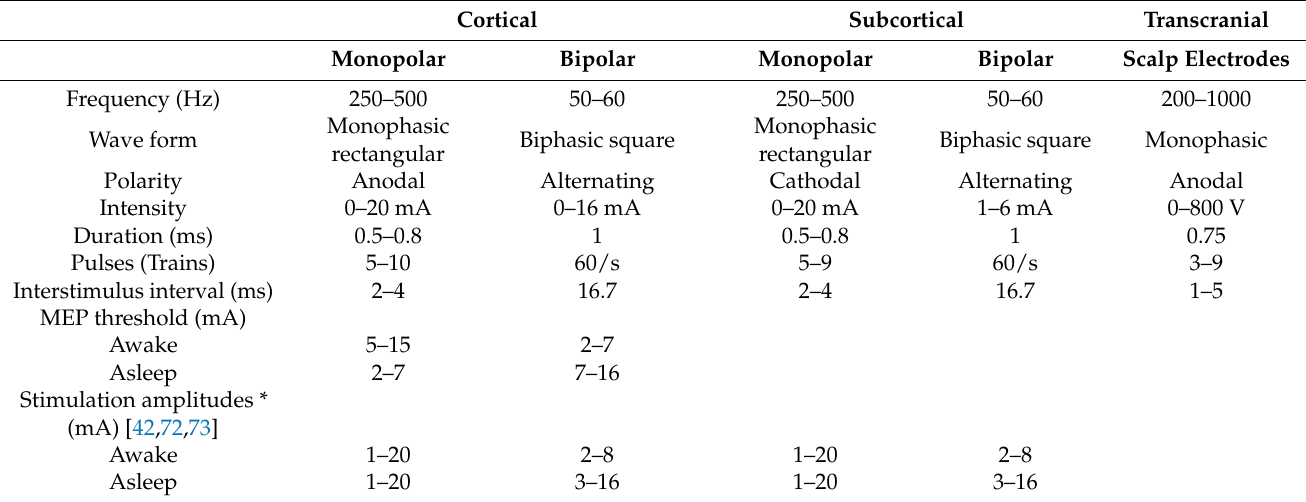
Table 2. Overview of intraoperative motor mapping parameters.